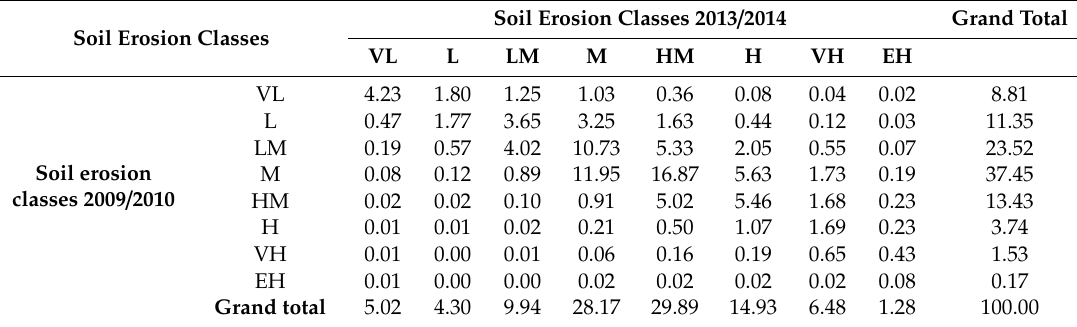
Table 2. Change the soil erosion matrix classes from 2009 / 2010 to 2013 / 2014 (%). Soil Erosion